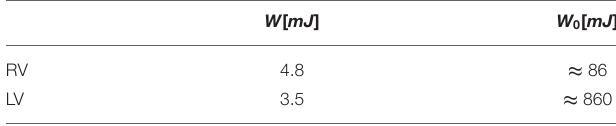
TABLE 1 | Systolic work, W , associated with blood flow and that, W 0 , required to overcome afterload